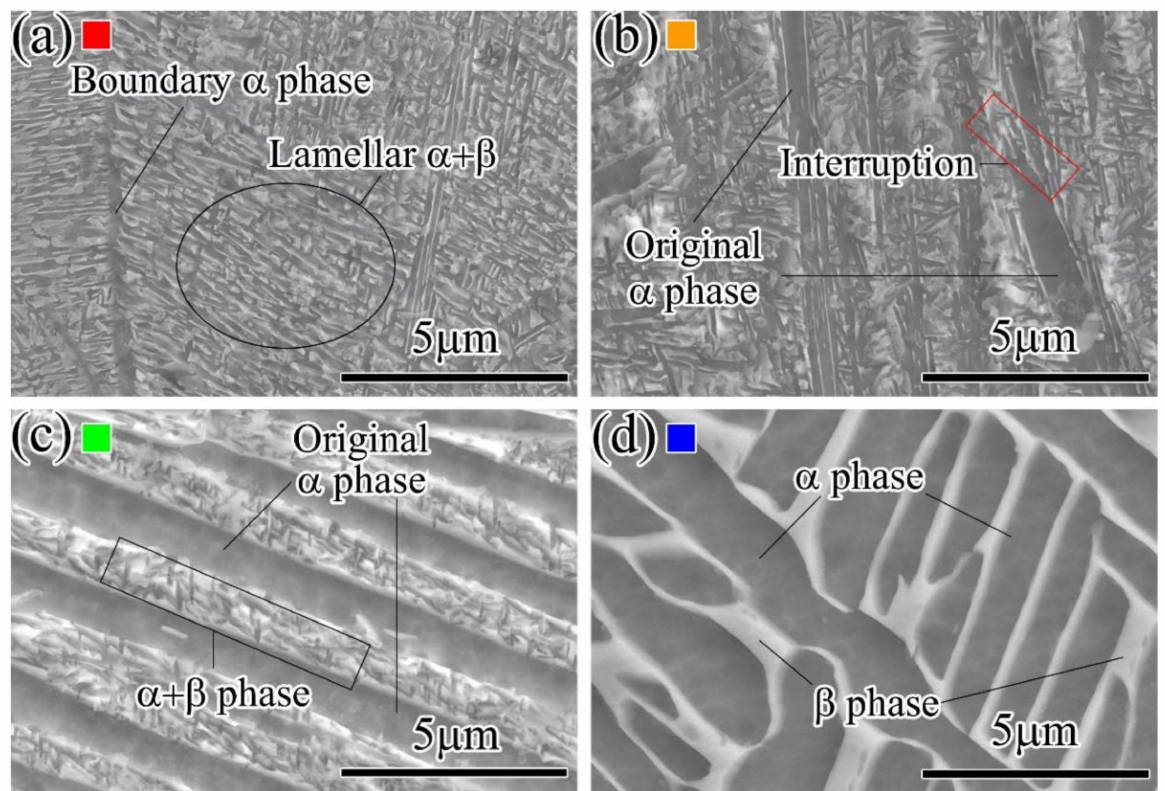
Figure 4. SEM microstructure pictures of different zones of the IFW joint under high microscope magnification ( a ) WZ; ( b ) TAMZ; ( c ) HZ ( d )